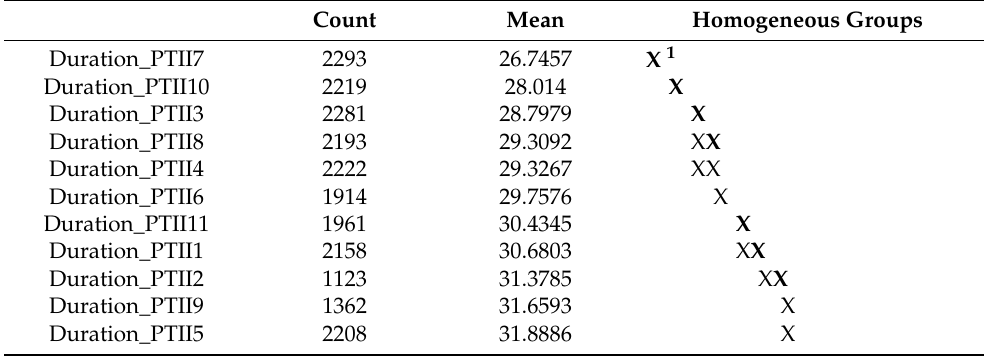
Table 6. Multiple range test after the application of the PTII WQA. Count